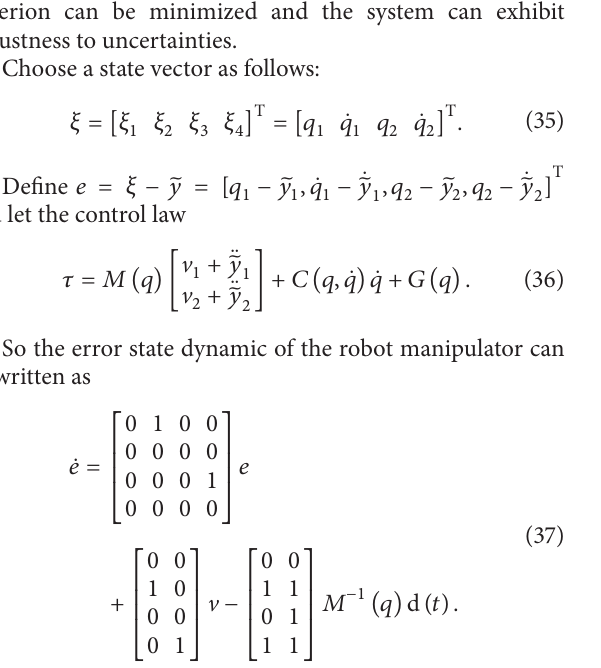
Figure 2: The tracking error 𝑒 1 (𝑡) of position 𝑞 1 for link 1.